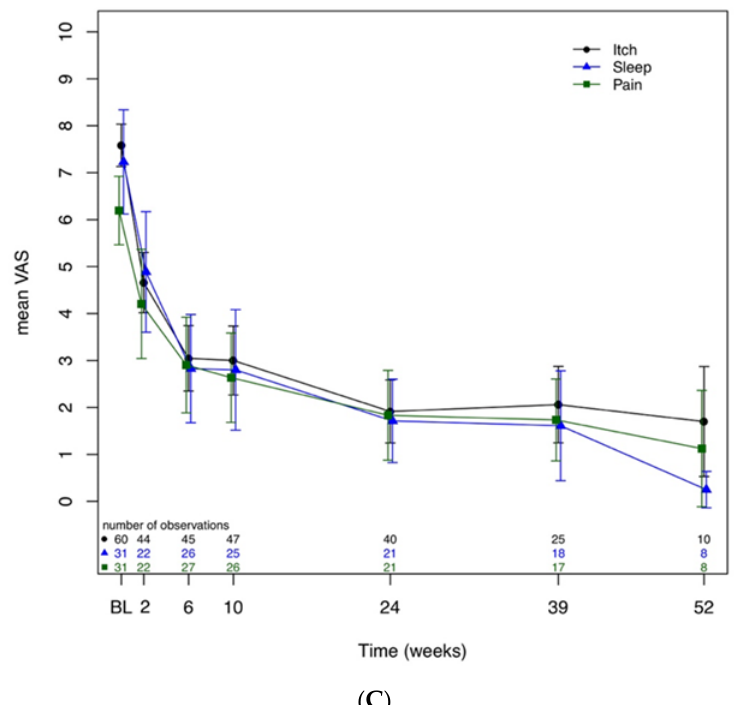
Figure 1. ( A ). Percentage of patients with an Investigator Global Assessment (IGA) of 0 or 1. Numbers within bars represent number of observations. ( B ). Eczema Area and Severity Index (EASI), Scoring Atopic Dermatitis (SCORAD), Body Surface Area (BSA)—Mean percentage change from baseline up to 52 weeks. ( C ). Improvement of the variables itch, sleep and pain (visual analog scale (VAS)) from baseline up to 52 weeks.